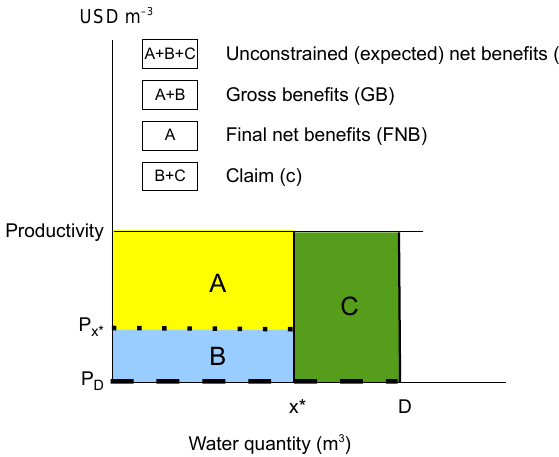
Figure 7. Demand curve for the case study. D: quantity of water demanded for a time period; x ∗ : quantity of water allocated for a time period; P: price of